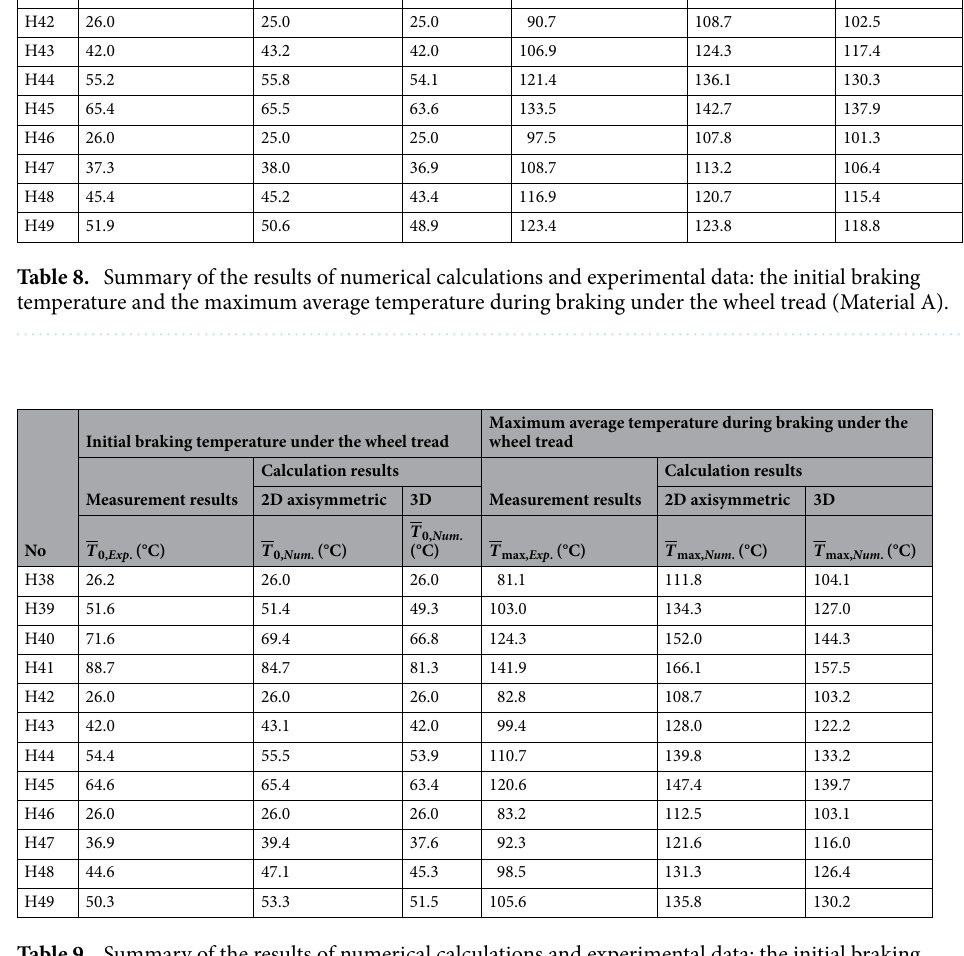
Table 9. Summary of the results of numerical calculations and experimental data: the initial braking temperature and the maximum average temperature during braking under the wheel tread (Material B).